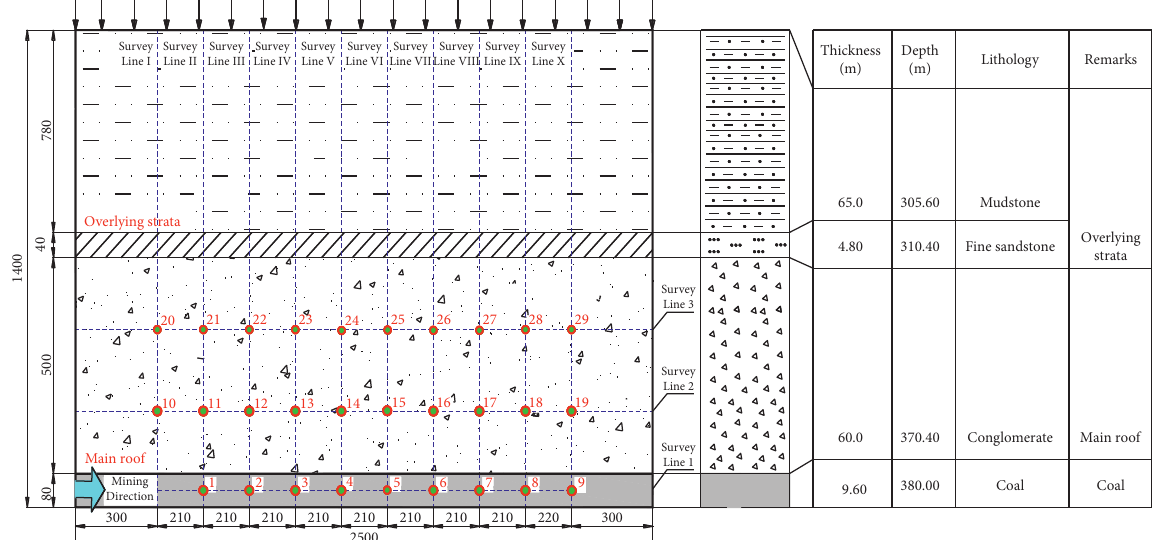
Figure 2: Stope model of extra-thick coal seam mining under the THR.